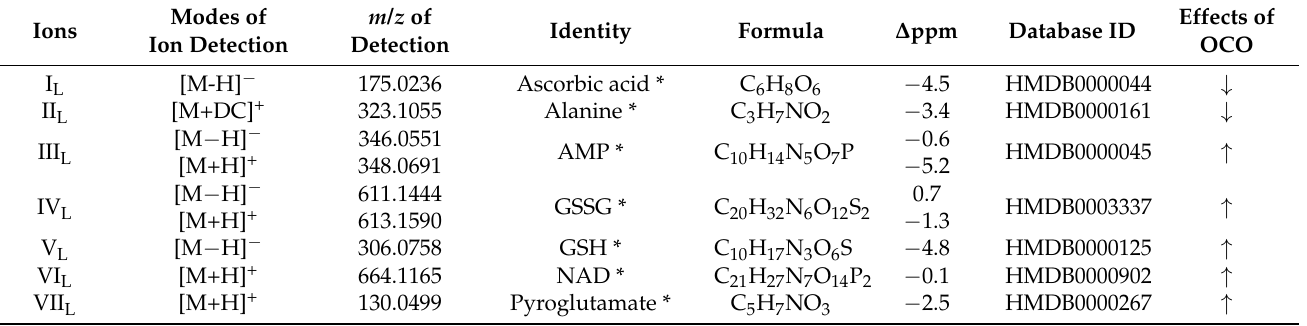
*: confirmed by authentic